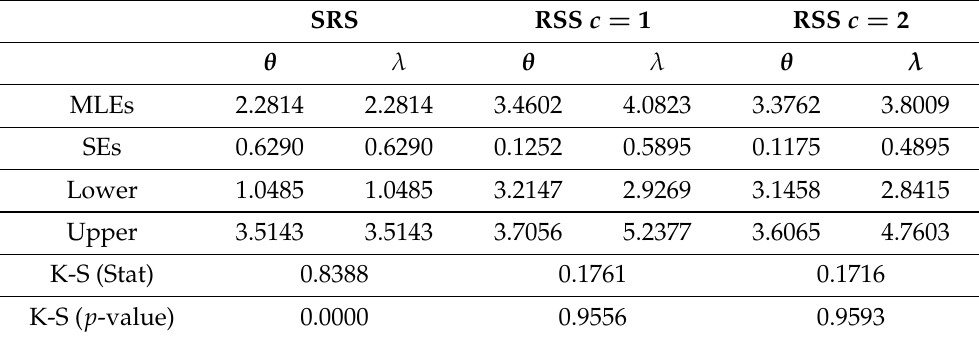
Table 17. MLEs of the parameters θ and λ of the GB( θ , λ ) distribution with lower and upper bounds of CI, SEs, Kolmogorov-Smirnov (K-S) (stat), and (K-S) p -value under the SRS and RSS schemes when n =